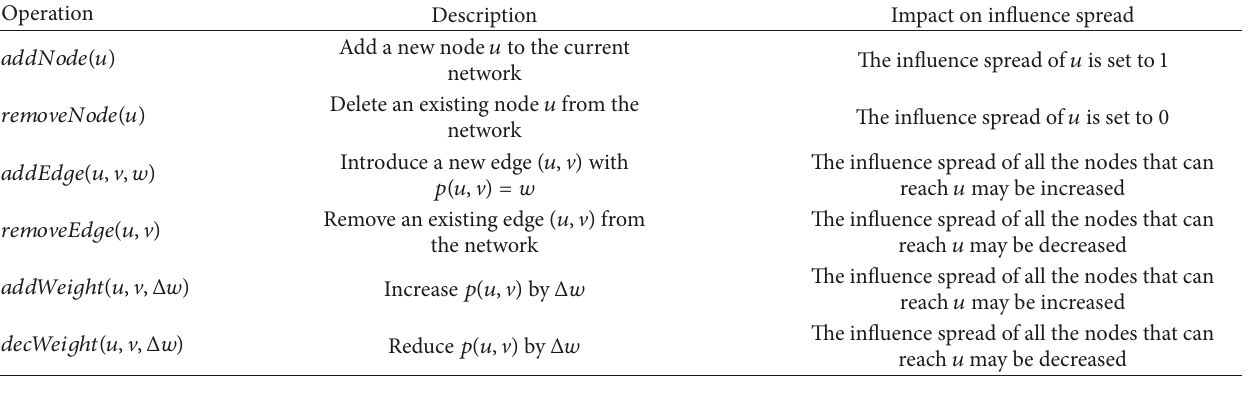
Table 1: Details of six types of basic